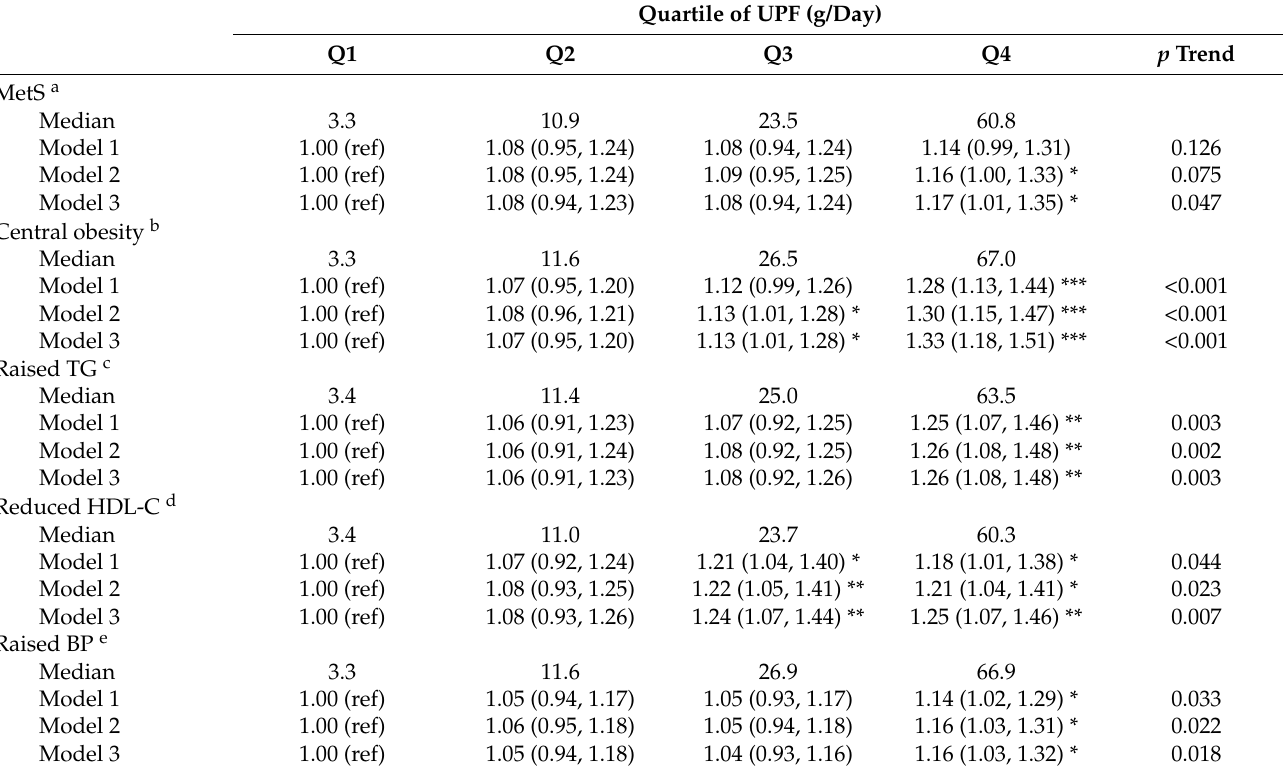
Table 2. Associations of UPF consumption with MetS and its